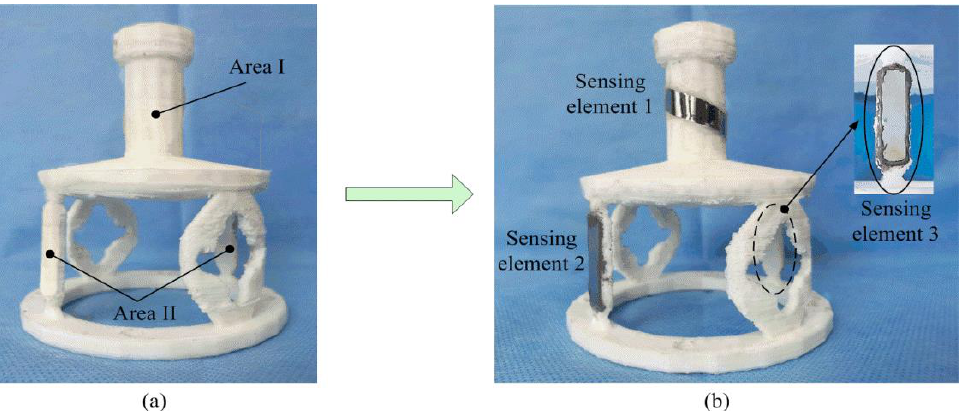
Figure 6. The prototype of the proposed sensor: ( a ) the elastomer structure and ( b ) the position of the three sensing elements.